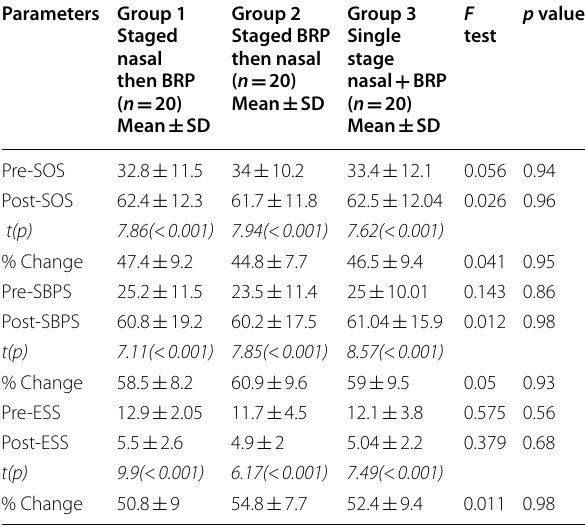
Table 2 Nasal surgeries done with BRP in OSA patients undergoing staged and single‑stage multilevel procedures Nasal surgery Freq